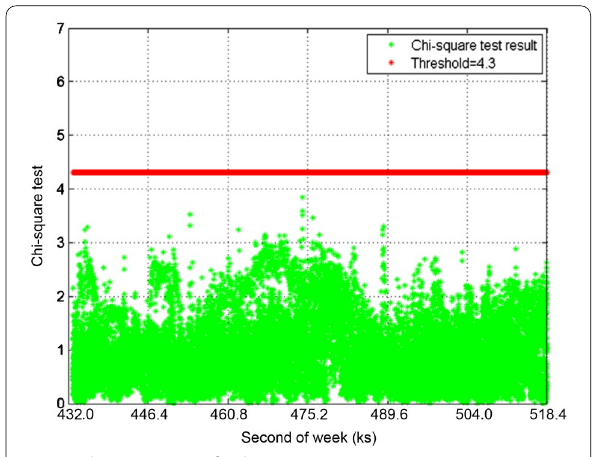
Fig. 9 Chi-square test of ephemeris corrections